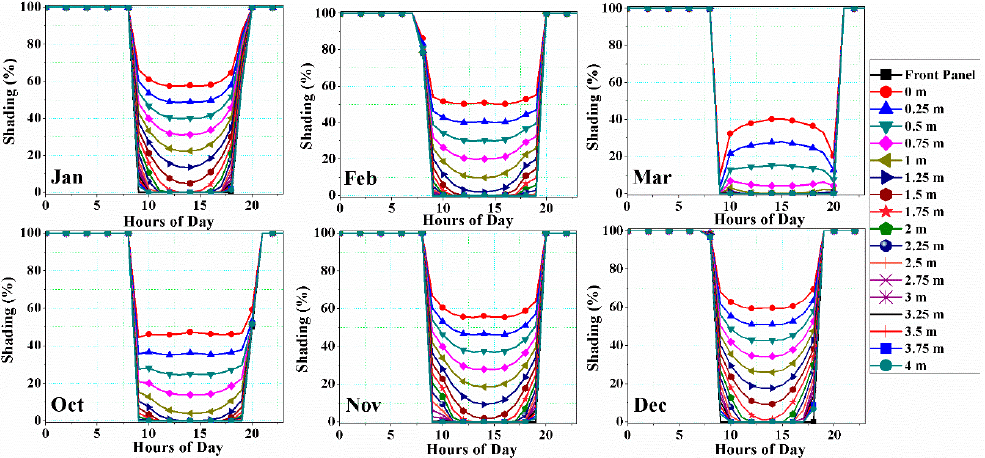
Figure 7. Self-shading losses for critical months of January, February, March, October, November, and December.